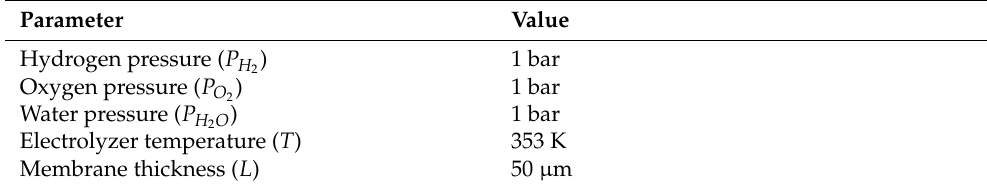
Table 3. Electrolyzer working conditions for validation.